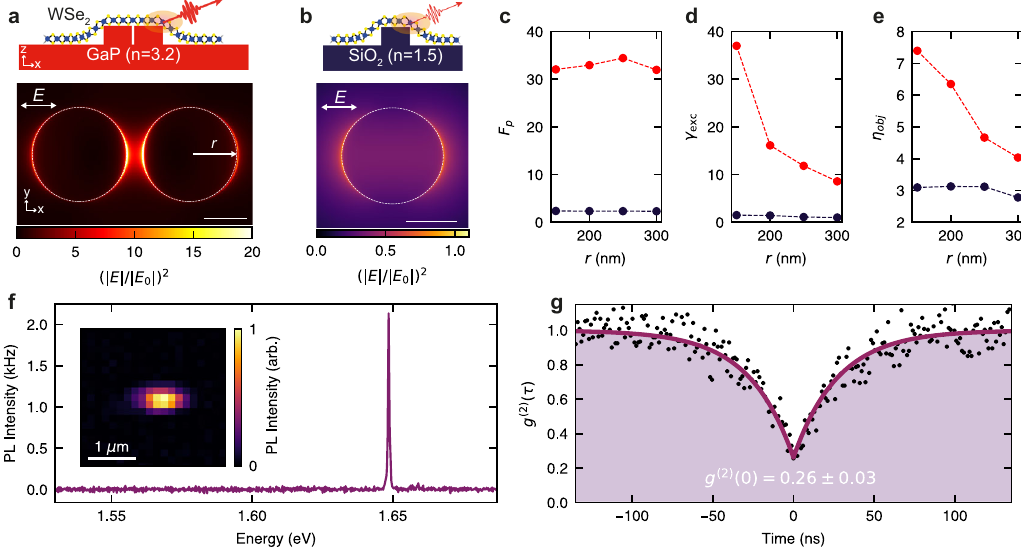
Fig. 1 Optical properties of nanoantennas and single-photon emitters in monolayer WSe 2 . a , b Top panel: schematics of monolayer WSe 2 on top of GaP nanoantennas ( a ) and SiO 2 nanopillar ( b ). Lower panel: calculated relative intensity of the electric fi eld in the scattered wave ( E ) over that in the incident wave ( E 0 ). Results are shown for ( a ) a GaP dimer nano-antenna ( r = 150 nm, h = 200 nm, gap = 50 nm) and ( b ) SiO 2 nanopillar ( r = 150 nm, h = 100 nm). The calculated intensity is shown for the plane at the top of each structure. Scale bar: 150 nm. c – e The calculated Purcell enhancement factor ( c ), excitation rate ( d ), and light collection ef fi ciency ( e ) for a dipole emitter placed at the position of the highest fi eld enhancement shown in ( a ) and ( b ) of the GaP dimer nanoantennas (red) and SiO 2 nanopillars (dark blue) relative to the same parameters for this dipole in a vacuum. See further details in “ Methods “ and Supplementary Note I. f A T = 4 K PL spectrum of a WSe 2 SPE on a GaP nano-antenna ( r = 250 nm, h = 200 nm, gap = 50 nm), excited` with a 638 nm pulsed laser with 20 MHz repetition rate and an average power of 15 nW. Inset: map of the integrated PL intensity of this monolayer ( T = 4 K). g Second-order photon correlation curve for the PL signal in ( f